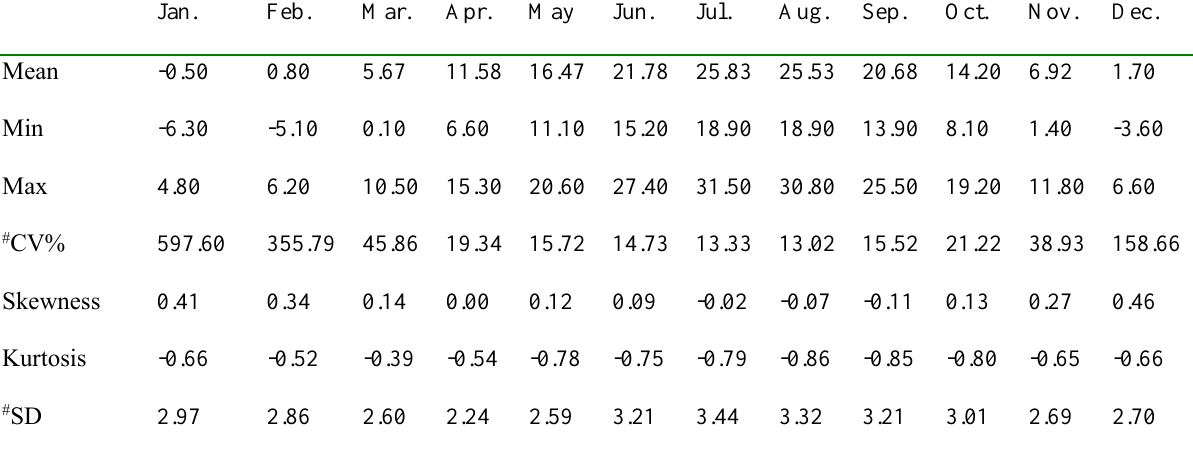
Table 1. Descriptive statistics of mean monthly temperatures measured from 1975 to 2010 Spatial